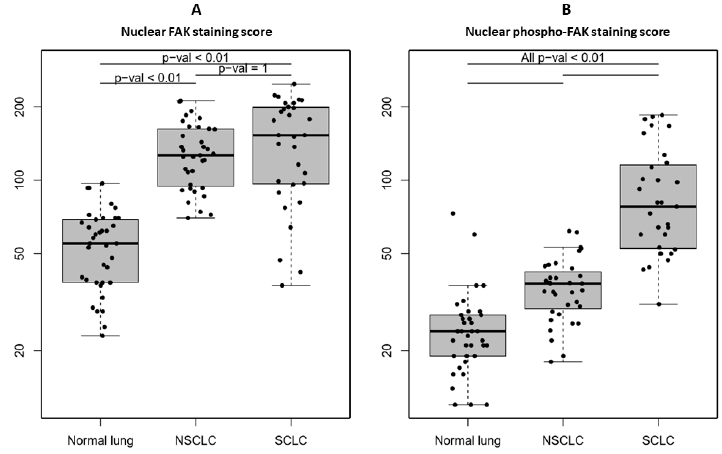
Figure 4. Quantification of nuclear FAK and nuclear phospho-FAK (Y397) expression evaluated by multiplex immunofluorescence immunohistochemistry in 37 normal lung, 95 non-small-cell lung cancer (NSCLC), and 105 small-cell lung cancer (SCLC) tissues: ( A ) Nuclear FAK staining score: Percentage (%) of FAK-stained nucleus area multiplied by (×) nuclear FAK mean intensity, ( B ) nuclear phospho-FAK (Y397) staining score: (% of phospho-FAK-stained nucleus area of low intensity × 1) + (% of phospho-FAK-stained nucleus area of medium intensity × 2) + (% of phospho-FAK-stained nucleus area of high intensity × 3). Each dot represents one sample. Data presented as the mean ± S.D. p -values were obtained using linear models and adjusted for multiple testing using the Bonferroni method.